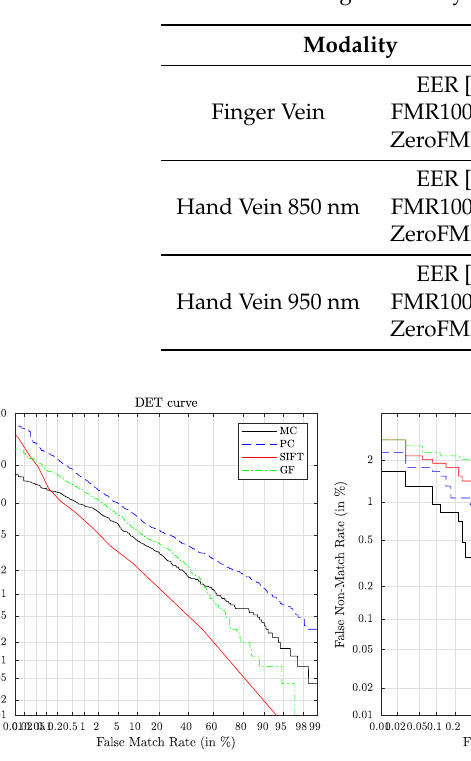
Figure 10. DET plots for finger vein ( left ), hand vein 850 nm ( middle ) and hand vein 950 nm ( right Single modality DET plots: finger vein (left), hand vein 850 nm (middle) and hand vein 950 Figure 10. :::: :::::::: : nm (right) performed best, followed by MC and GF while PC performed worst. On the hand vein 850 nm subset, 572 :::: ::: :